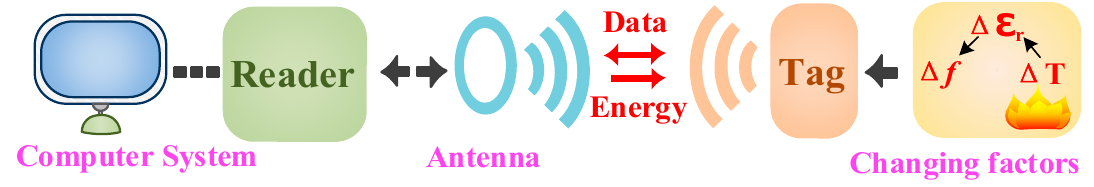
Figure 1. Principle of chipless radio frequency identification (RFID) systems for temperature sensing.